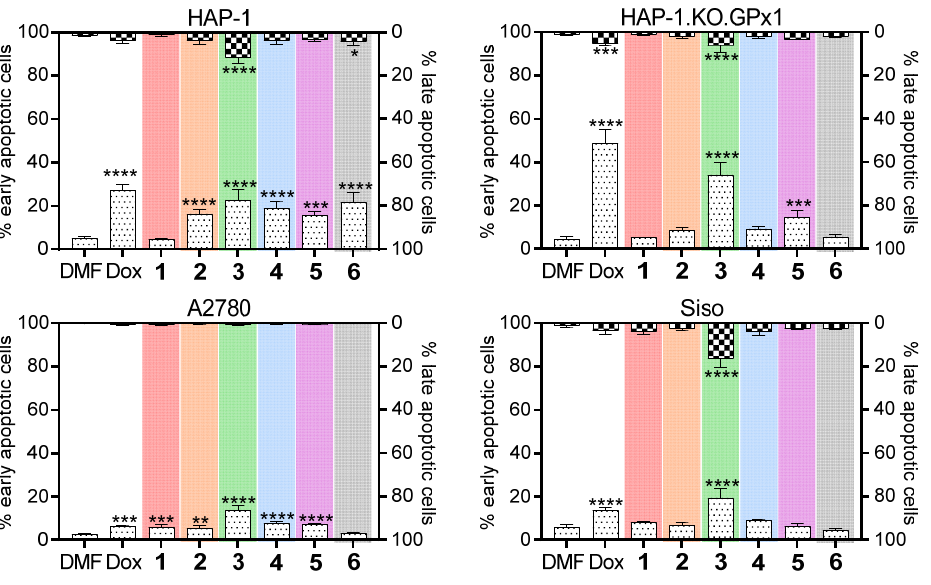
Figure 14. Induction of apoptosis assessed via annexin V/PI flow cytometric assay after treatment for 24 h with the respective pentathiepin 1 – 6 (IC 90 ) or 0.5 µ M of doxorubicin (Dox) as positive control. Negative control cells were incubated with the solvent DMF. Representative dot plots are provided in Figure S47. The fractions of early apoptotic cells (left y -axis, dotted bars) and late apoptotic cells (right y -axis, checkered bars) are displayed as mean with SD. Resulting gaps between the bars correspond to viable cells. Statistical analysis was performed with Prism 7 by one-way ANOVA and Dunnett’s multiple comparisons post hoc test. n = 3 independent experiments. * p < 0.05, ** p < 0.01, *** p < 0.001, **** p <